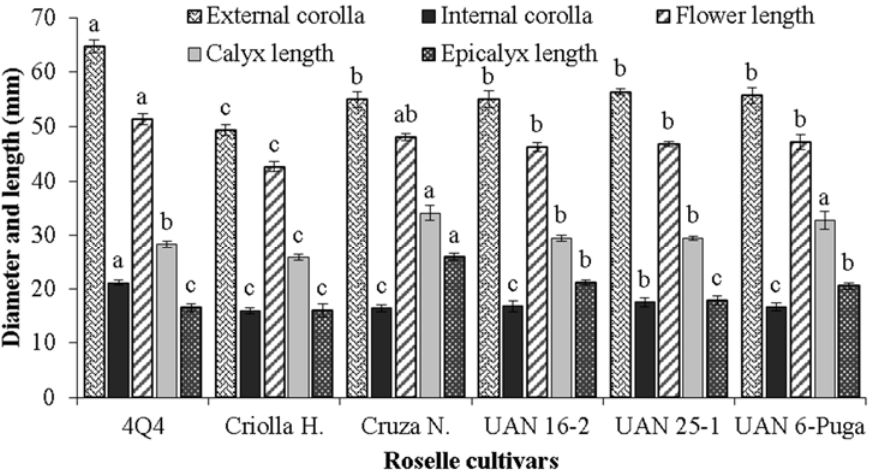
Figure 3. External and internal diameter of corolla and length of flower, calyx and epicalyx of different cultivars of roselle. Different letters on bars corresponding to the same response variable indicate significant differences between cultivars according to the Tukey test ( p ≤ 0.05). Vertical bars correspond to the standard deviation.